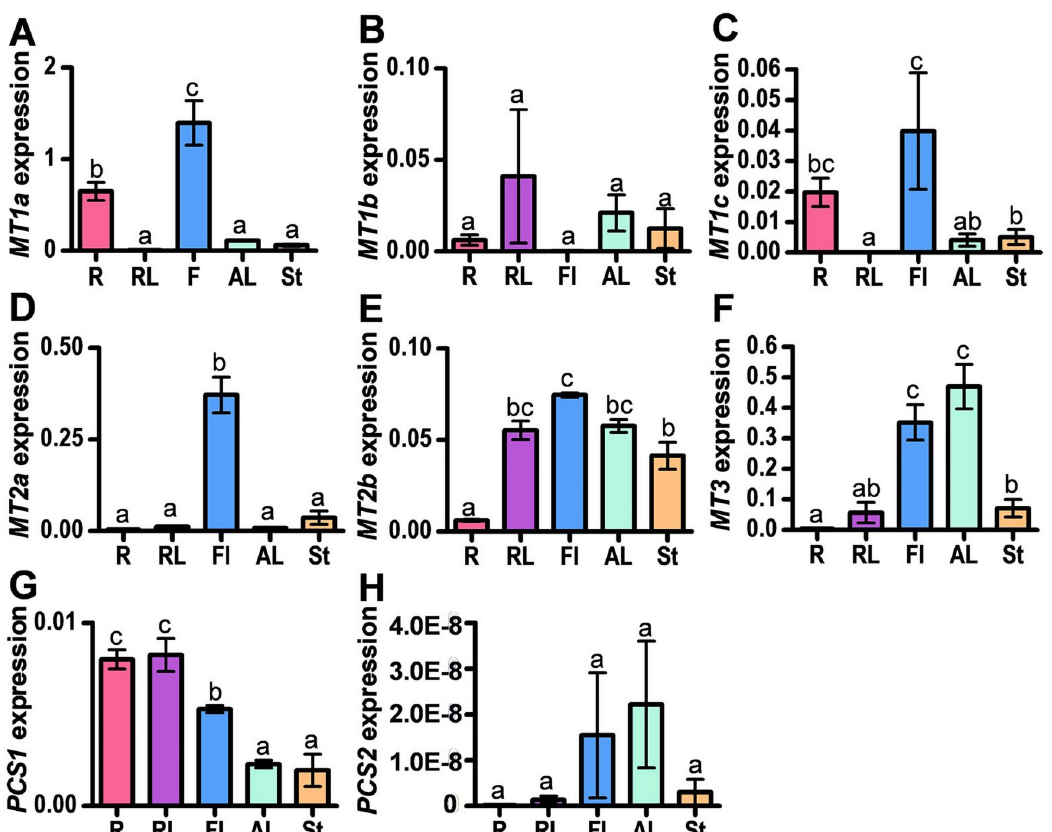
Fig 3. Tissue specific expression of BrMTs and BrPCSs in B . rapa . To analyze the expression of B . rapa Cd tolerance genes ( BrMTs and BrPCSs ), qRT-PCR was performed with cDNA synthesized from total RNA as a template and gene-specific primers (S1 Table). The expression levels of Cd tolerance genes were normalized to the level of actin, and the values indicate the average and standard error (biological replicates: 3). Different letters indicate that the means (between various samples) are significantly different by the Tukey HSD test (P � 0.05). R, roots from one-month old plants; RL, rosette leaves from one-month old plants; Fl, flower; AL, leaf from flowering plants; St, stem from flowering